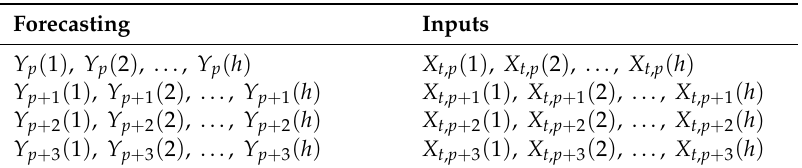
Table 5. One-step-ahead prediction